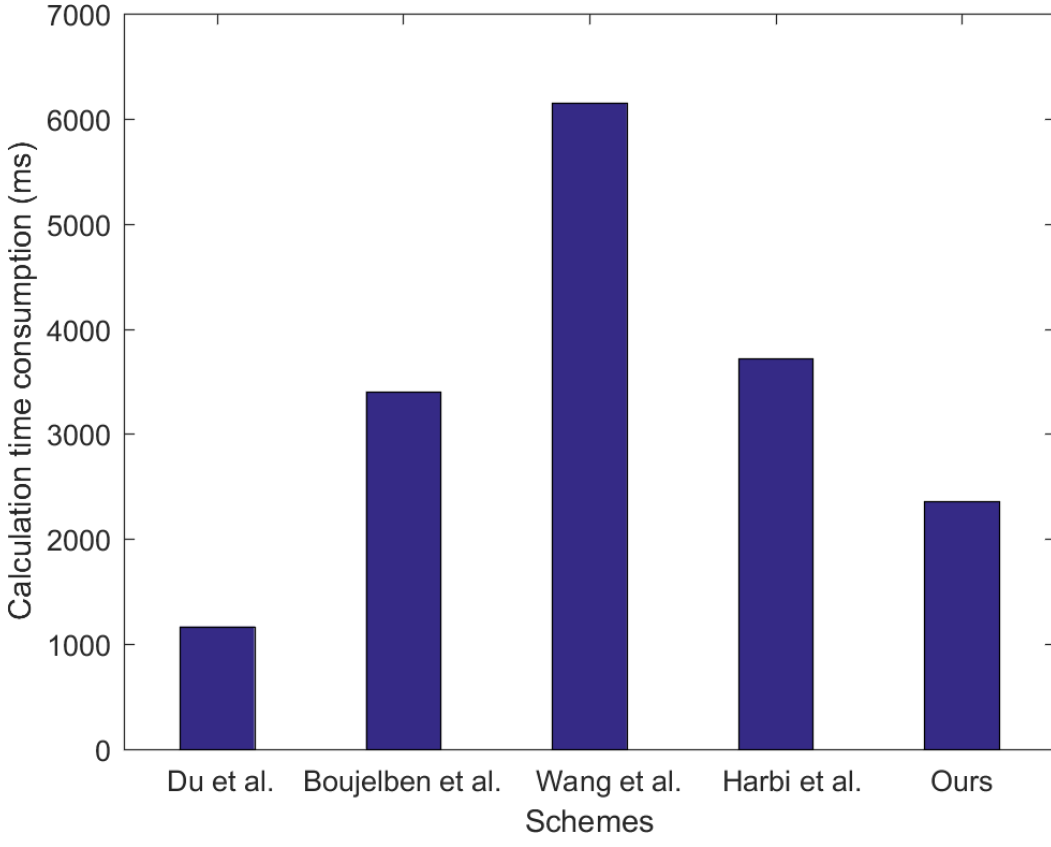
Figure 5. The comparison of calculation costs of the scheme.